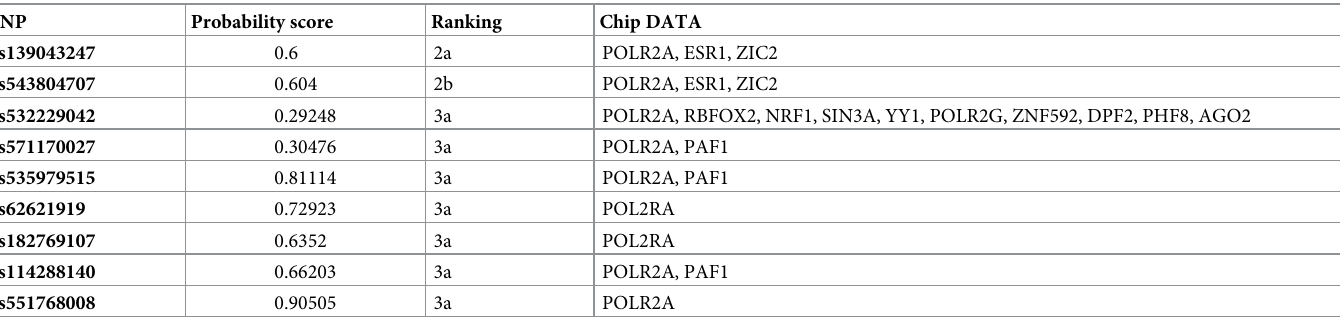
Table 9. Regulome DB data for non-coding SNPs of